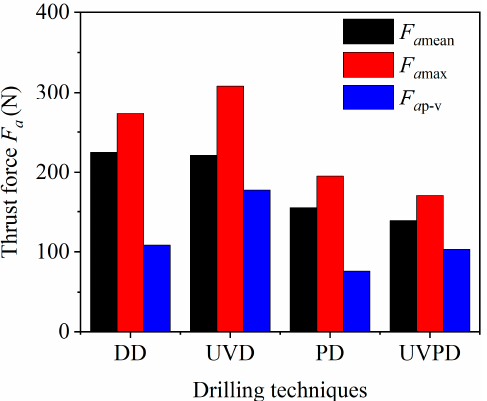
Figure 4. Thrust force characteristic values under different drilling techniques. ( n = 1200r/min, v f = 36 mm/min, f = 20 KHz, A = 2.2 μ m, Q = 1